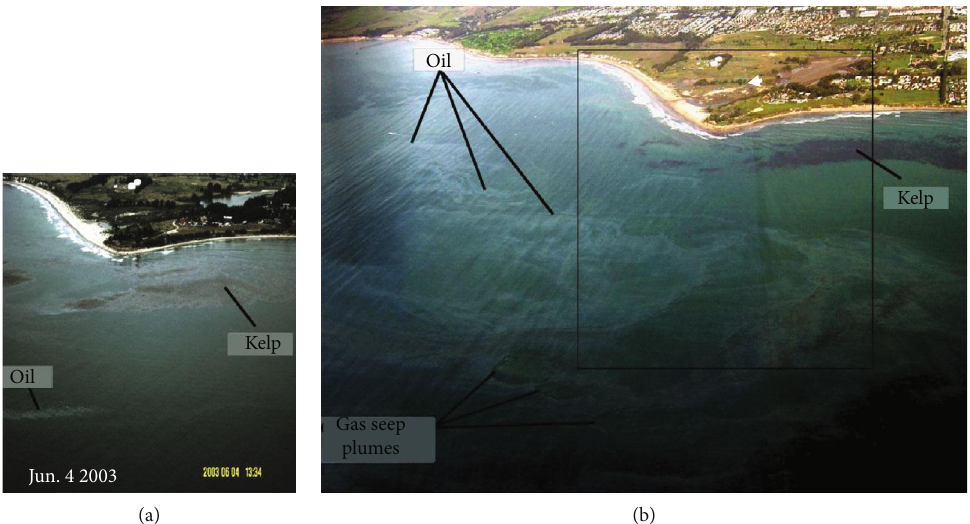
Figure 19: (a) Extensive oil slicks o ff shore Coal Oil Point following strong storms in Jan. 2005 and (b) comparison image for Jun. 2003. From Del Sontro [190]. Photo courtesy: Chris McCullough (DOGGR) and Ira Leifer. WCS: West Campus Station, location